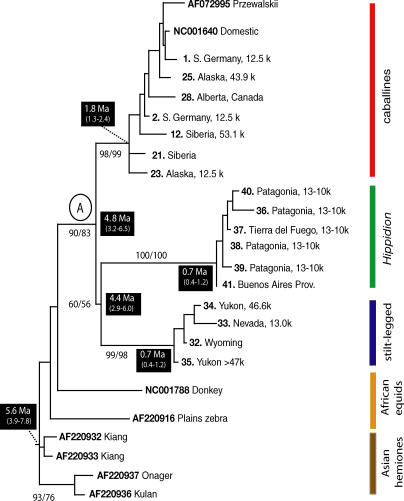
Phylogeny of Recent and Pleistocene EquidsThe maximum likelihood tree was constructed with two fragments of the mitochondrial control region (583 bp and 133 bp in the HVR1 and HVR2 regions, respectively). Bayesian analysis produced a similar topology. The general time-reversible substitution model was used in both techniques. Black numbers above/beside nodes are posterior probabilities and bootstrap values, respectively (only values > 50% are shown). White numbers on black background are divergence times as calculated from the molecular data. Numbers/letters in bold at the beginning of each specimen's name are sample numbers or GenBank accession numbers. Labels of prehistoric specimens are followed by their age, if available, in thousands of years. The outgroup (Rhinoceros and Ceratotherium) is not shown.